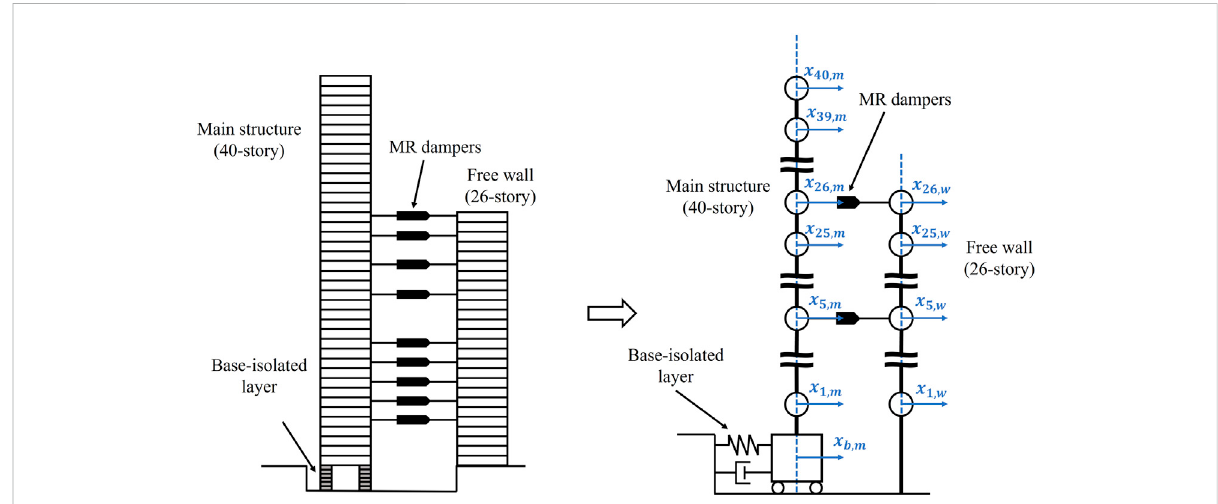
FIGURE 1 The model of the coupled buildings system with base isolation and building connecting.